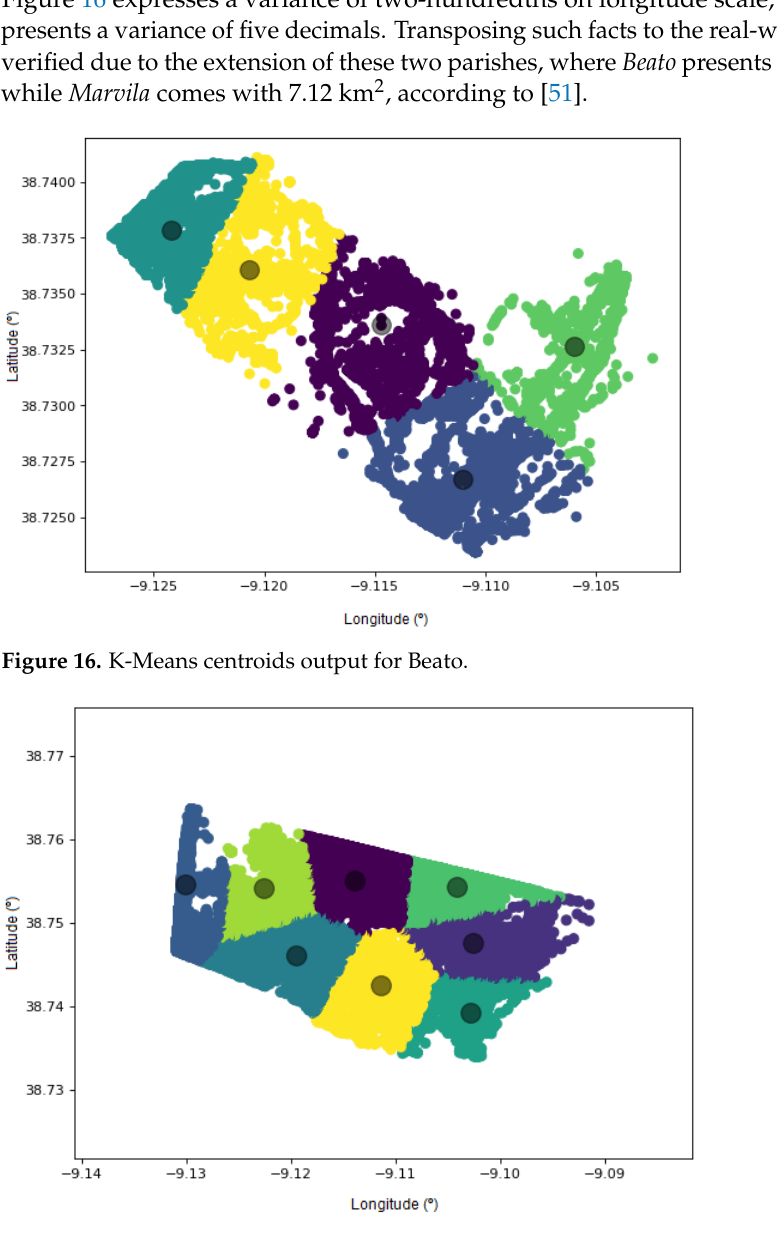
Figure 17. K-Means centroids output for